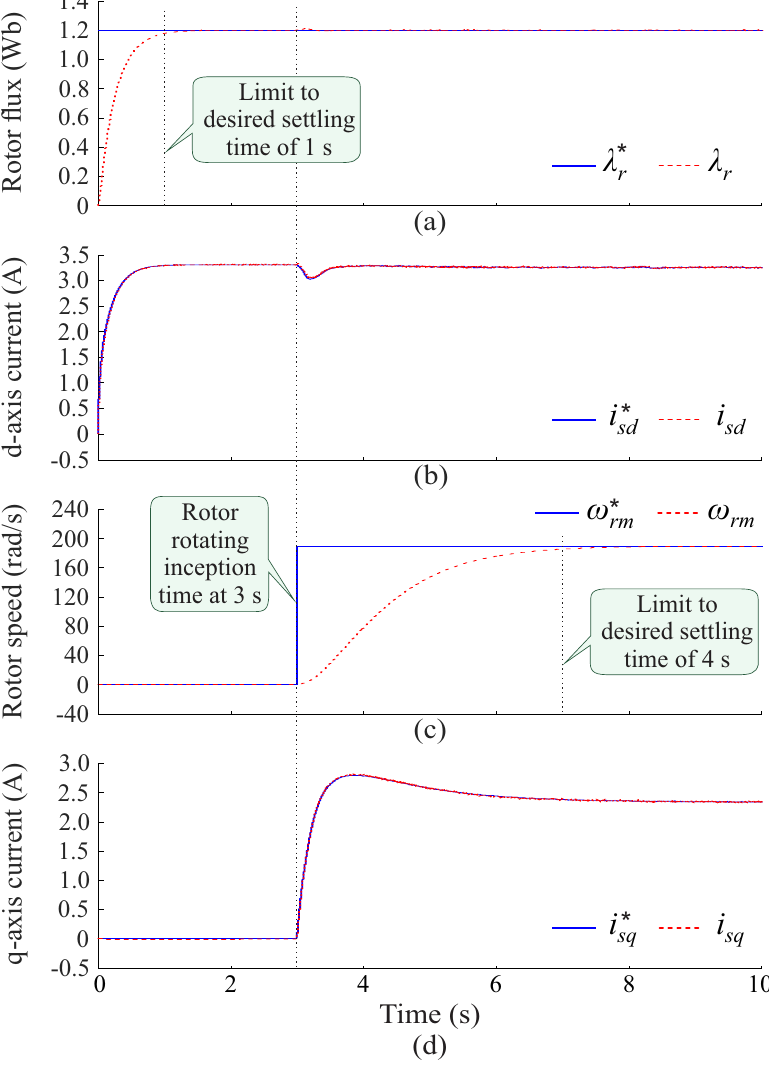
Figure 14. Dynamic responses from system’s controllers ( a ) rotor flux controller, ( b ) d -axis armature current controller, ( c ) rotor speed controller and ( d ) q -axis armature current